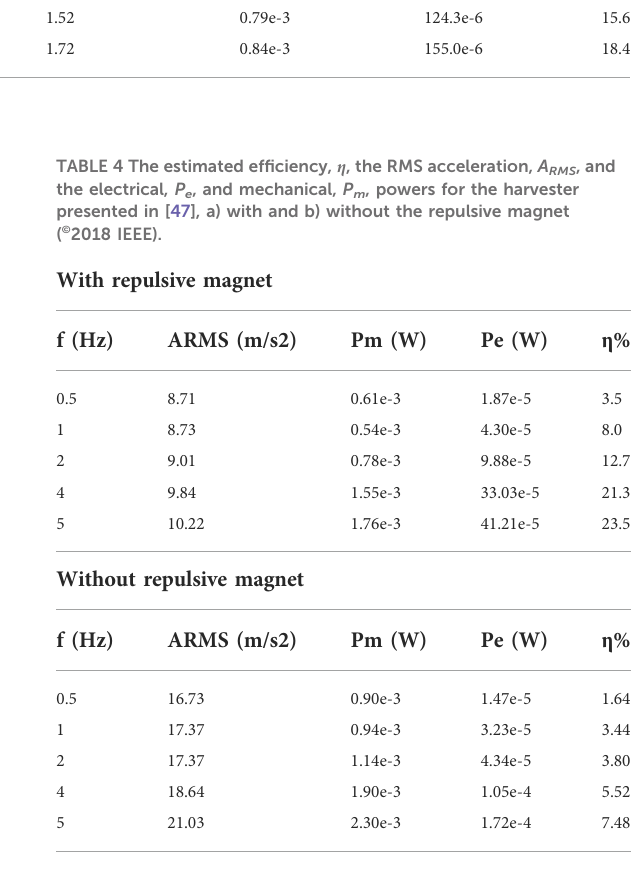
FIGURE 2 Schematization of the STB EH with the repulsive magnet ( © 2019 IEEE).